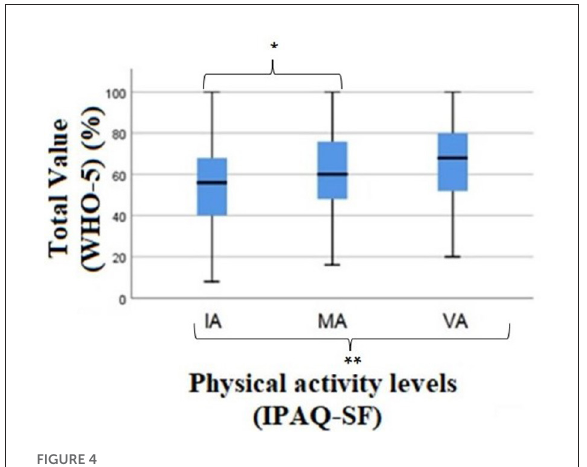
FIGURE4 Results of the Kruskal-wallis test for the comparison of total value (WHO-5) (%) between the levels of physical activity. WHO-5, WHO Well-Being Index (five); IA, Insufficiently Active; MA, Moderately Active; VA, Vigorously Active; PA, Physical Activity; IPAQ-SF, International Physical Activity Questionnaire; *Significant differences between the category IA and MA individuals ( p = 0.013); **Significant differences between IA and VA individuals ( p = 0.000).